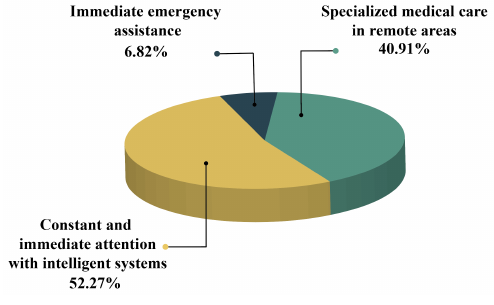
Figure 9. Healthcare benefits. Table 3. Summary of articles according to the healthcare